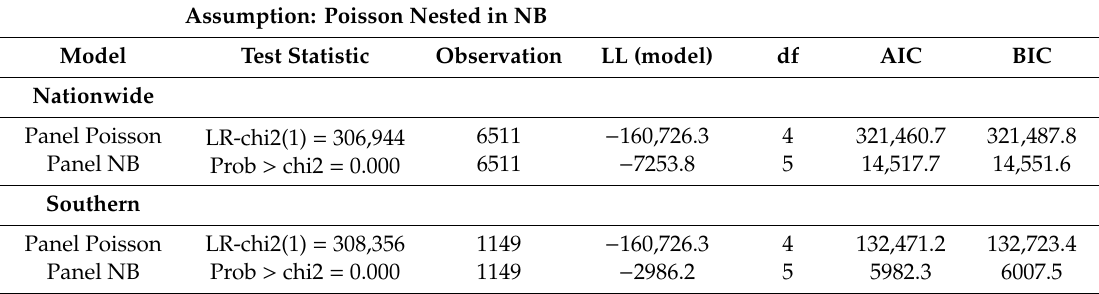
Table 6. Likelihood ratio test